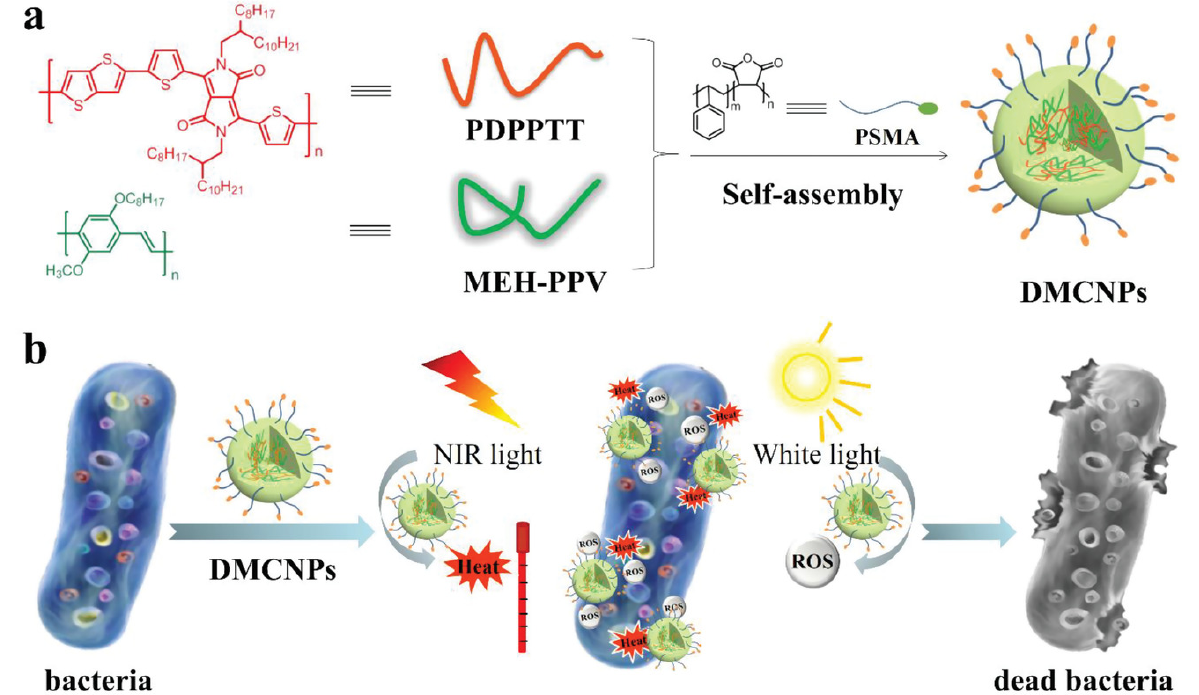
Figure 4. ( a ) Schematic illustration for the synthesis of utilized dual-mode antibacterial conjugated polymer nanoparticles (DMCPNs), ( b ) PTT- and PDT-based synergistic antibacterial activity of DMCPNs. Reproduced with permission from Ref. [78]. Copyright 2019 Wiley.